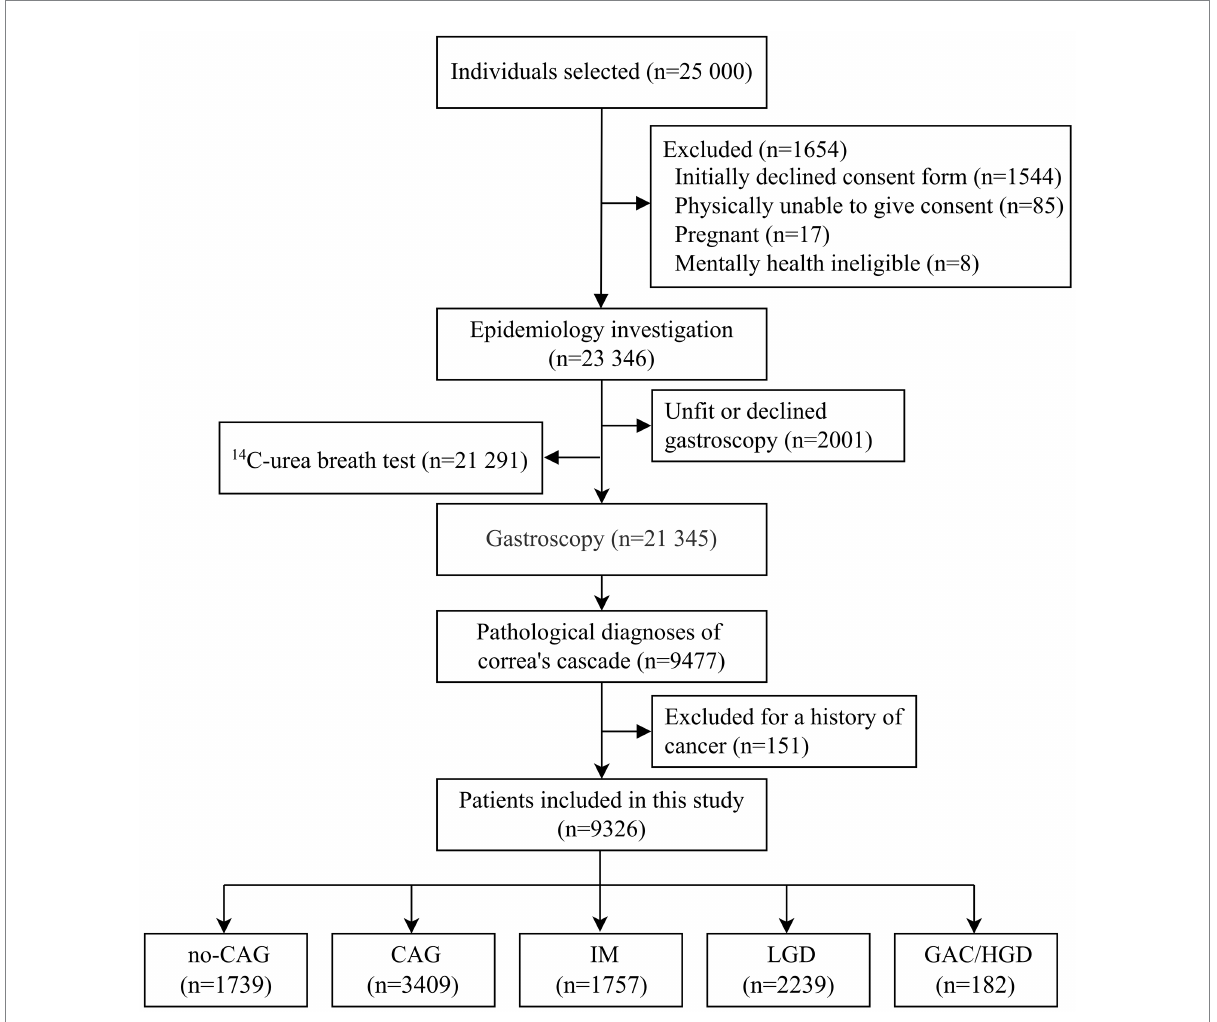
FIGURE 1 Flow chart of the study population. This figure depicts the study population screening process and the inclusion and exclusion criteria. no-CAG, chronic non-atrophic gastritis; CAG, chronic atrophic gastritis; IM, intestinal metaplasia; LGD, low-grade dysplasia; HGD, high-grade dysplasia; GAC, gastric